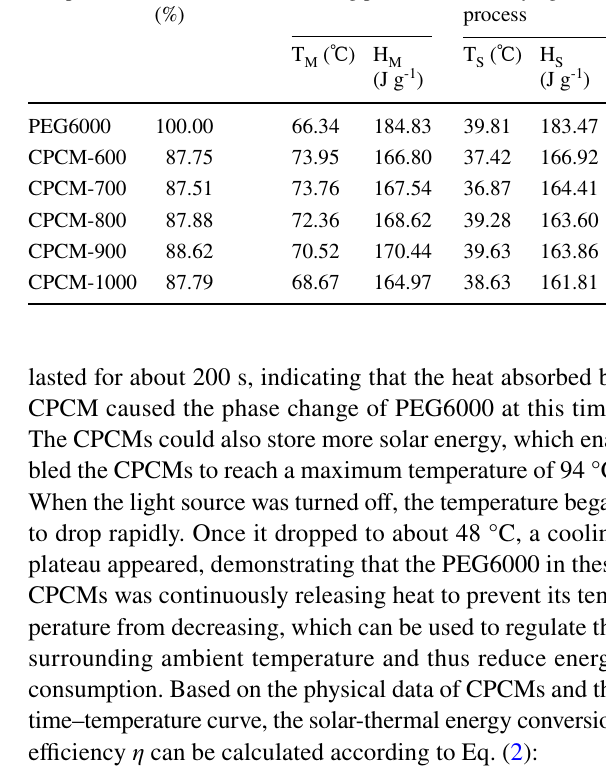
Table 2 Phase change parameters of pure PEG6000 and CPCMs Sample PEG content Melting (%)